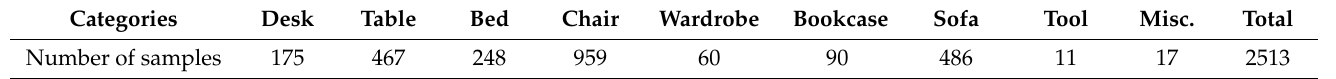
Table 4. The number of samples on the test set of pix3D for evaluation.